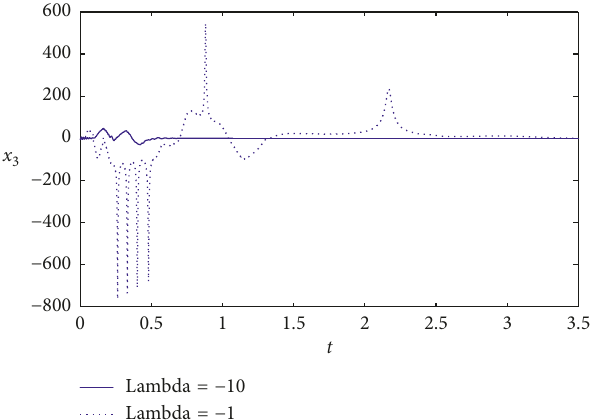
Figure 4: The time response of state x x